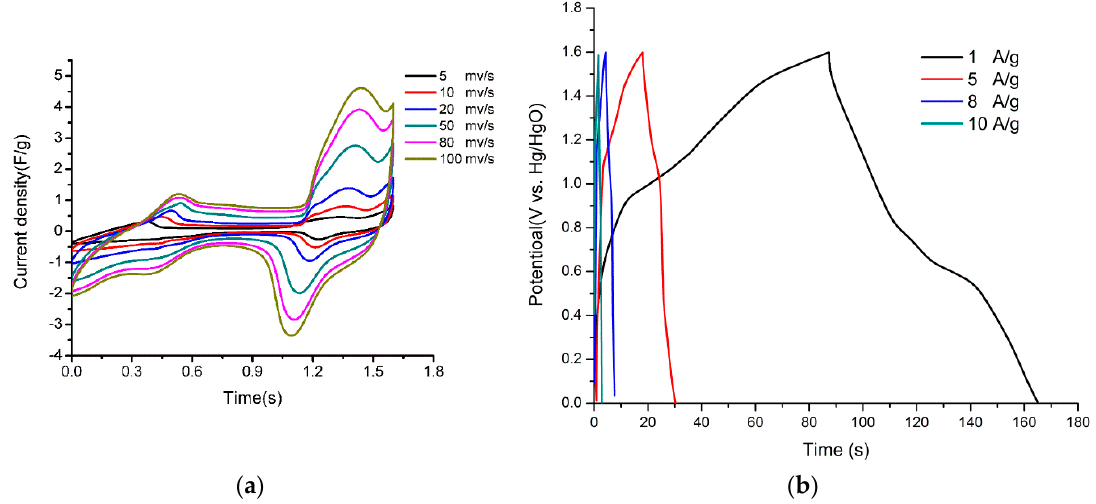
Figure 7. CV curves ( a ) and the charge–discharge curves ( b ) of the Ni@Cu-MOF/activated carbon asymmetric supercapacitor measured in a 6 mol L − 1 KOH electrolyte solution.